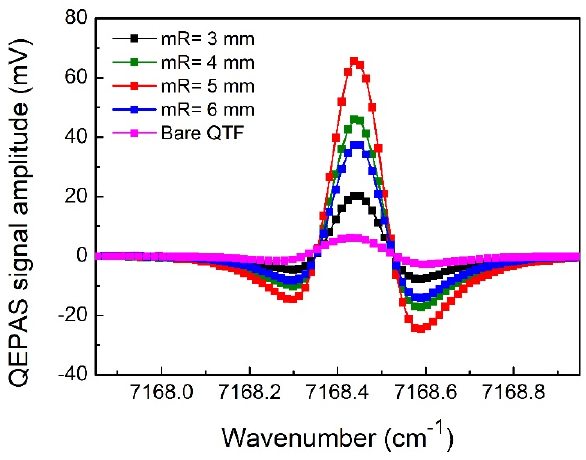
Figure 9. Experimental measured 2 f QEPAS signals using mRs with different lengths